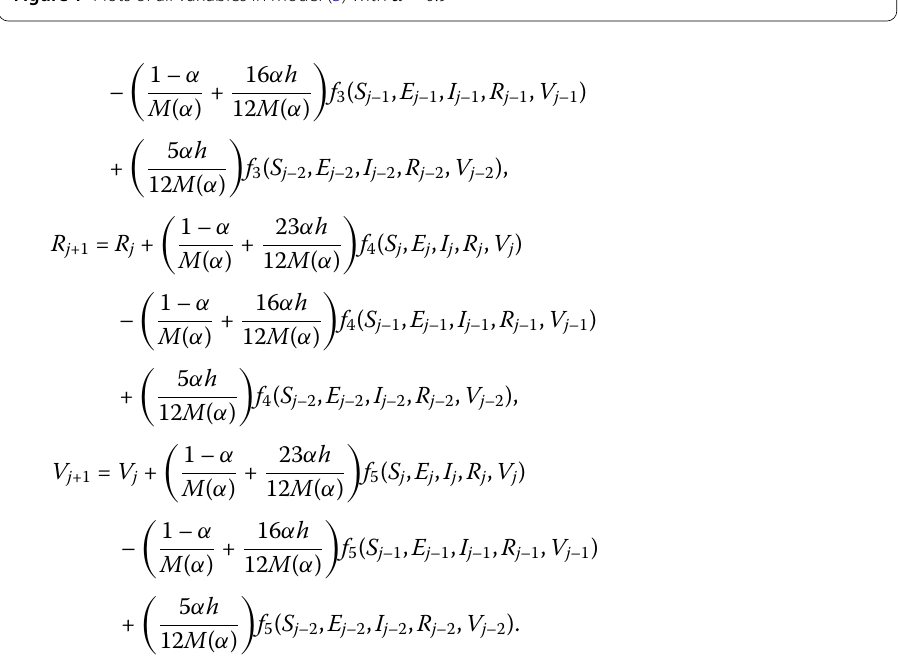
Figure 1 Plots of all variables in model (3) with α =